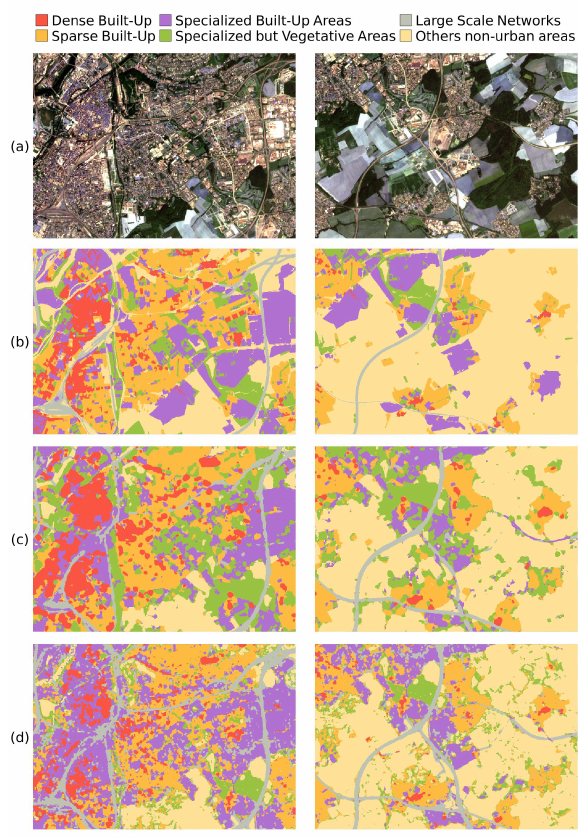
Figure 6. Visual results for two subsets over Metz. (a) is the Sentinel-2 RGB, (b) is the ground reference in a raster format, (c) U-Net-IRRG prediction and (d) U-Net-index prediction.